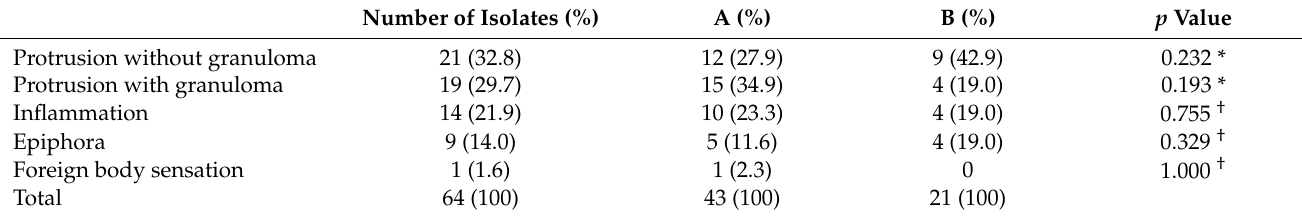
Table 2. Causes of plug removal.